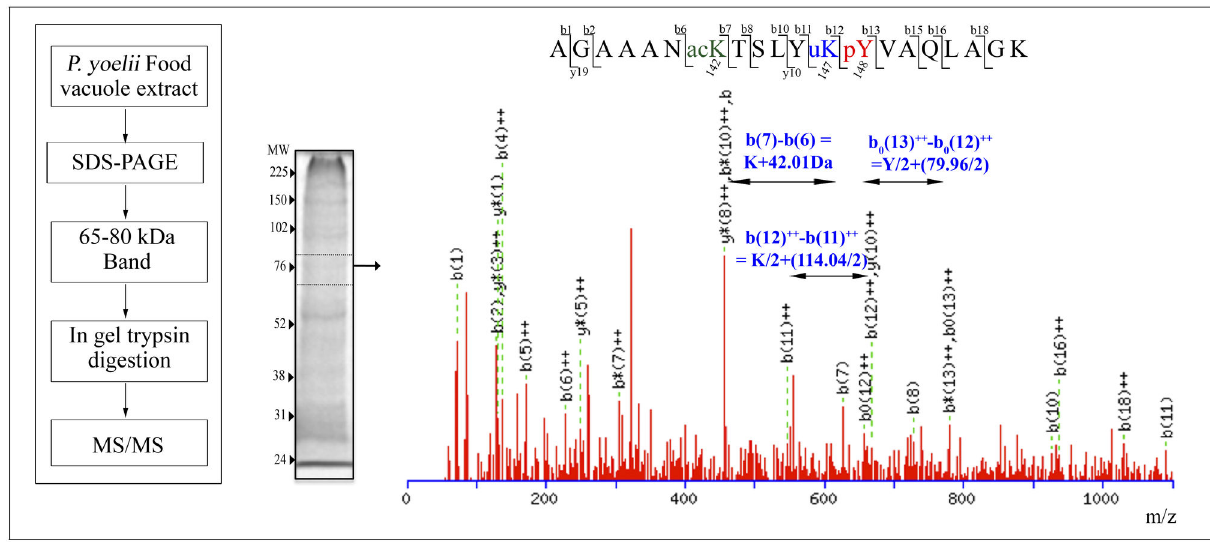
Figure 2. MS/MS spectrum of a peptide from P. yoelii enolase (Pyeno). Sequence covers residues 136-155 of Pyeno. Three different post-translational modifications are observed. K142 is acetylated, K147 has attached glycylglycyl residues through a trans- peptide linkage (a signature of ubiquitination) and Y148 is phosphorylated. ‘b’ ions corresponding to relevant modifications are marked with arrows along with aminoacyl residue mass + Δm for the modifying